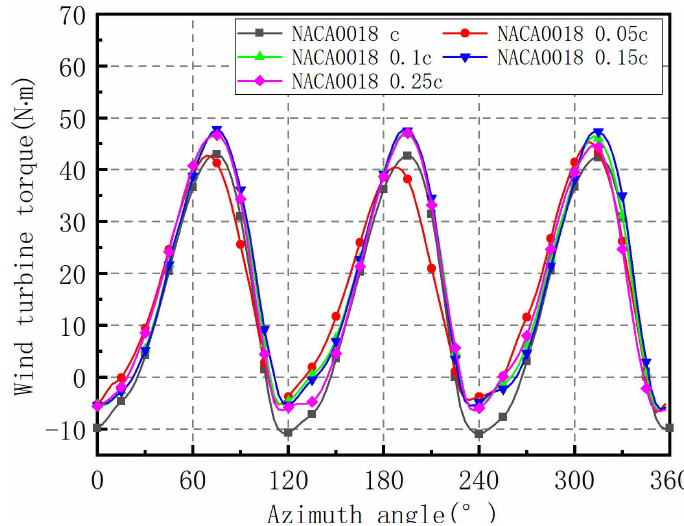
Figure 27. Curve of offshore wind turbine torque changing with azimuth (TSR = 1.5).